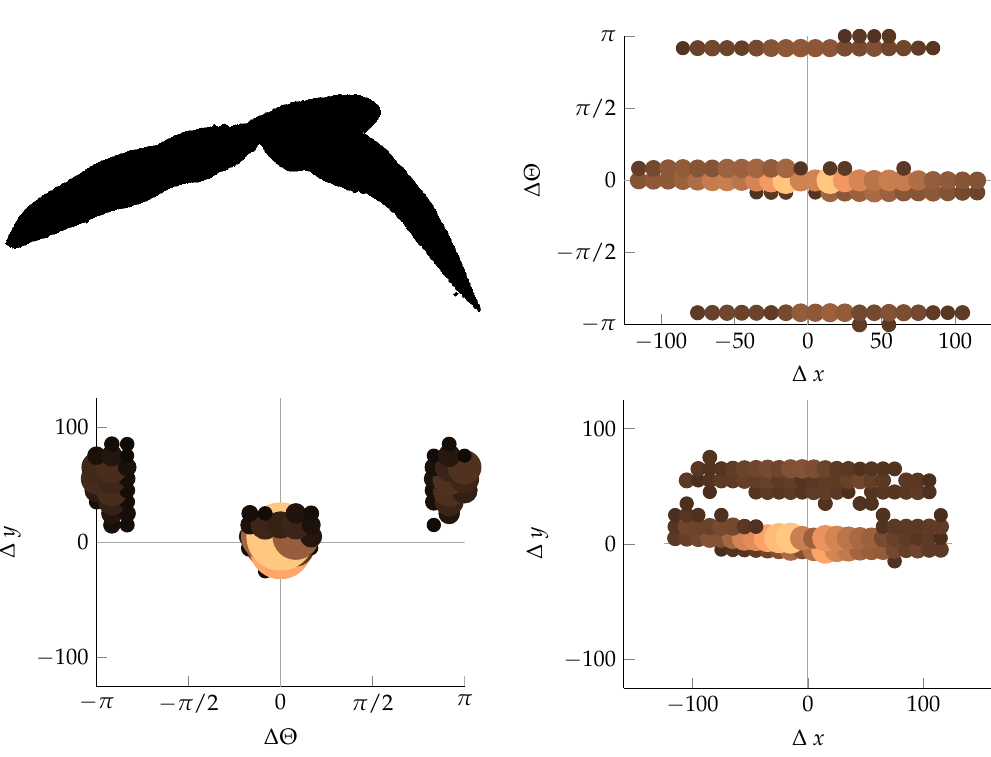
Figure B10. Monocot example